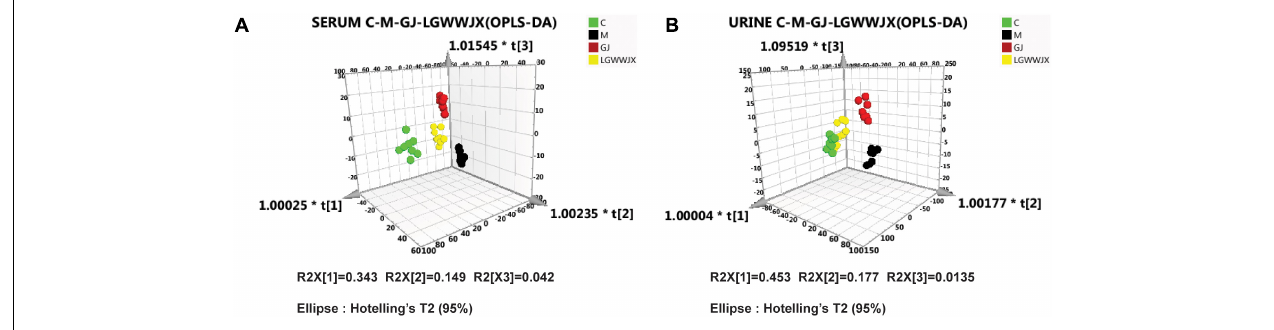
FIGURE 4 | OPLS-DA scores 3D plots. (A) Comparison of C (green), M (black), GJ (red), and LGWWJX (yellow) in serum (R 2 X = 0.855, R 2 Y = 0.896, Q 2 = 0.659). (B) Comparison of C (green), M (black), GJ (red), and LGWWJX (yellow) in urine (R 2 X = 0.817, R 2 Y = 0.899, Q 2 =